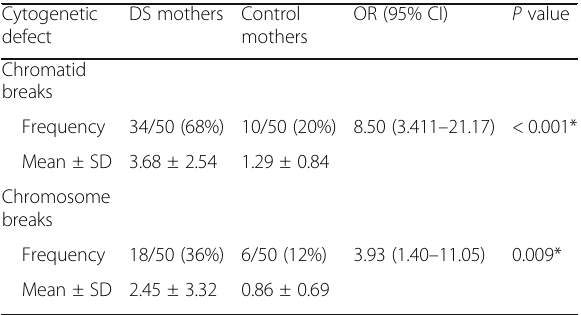
Table 3 The frequency of chromatid and chromosome breaks in young mothers with DS children and control